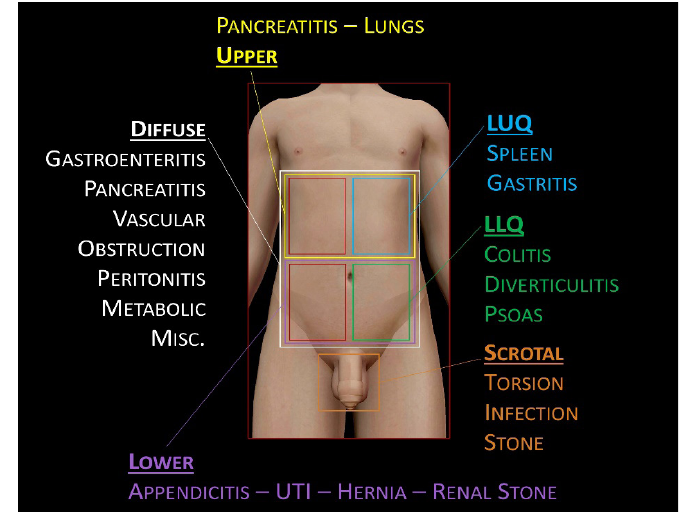
Image 2. Example differential diagnosis for abdominal pain based on location of the pain. 1 LUQ , left upper quadrant; LLQ , left lower quadrant; MISC , miscellaneous; UTI , urinary tract